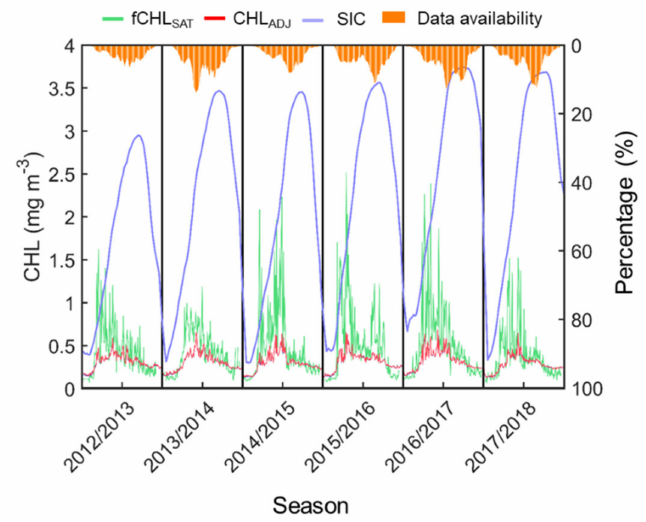
Figure 11. Time–series of spatially-averaged ( a ) fCHL SAT (green line) and ( b ) CHL ADJ (light red line) on the left y-axis and ( c ) SIC (light blue line) and (d) data availability for fCHL SAT (orange bar) on the right y-axis. Time–series are shown only in summertime (November to March) during 2012 / 2013 and 2017 / 2018 and are separated by vertical thick black lines. SIC and data availability are expressed on a 13-day moving